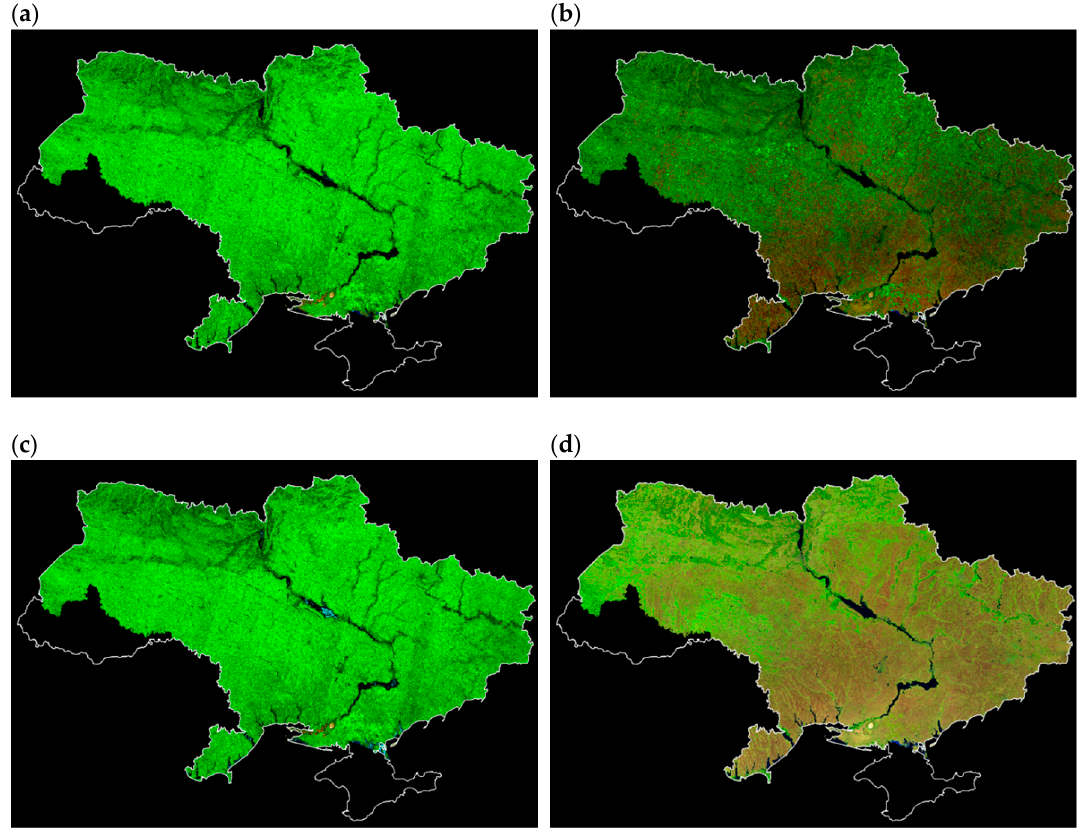
Figure 2. RGB images of seasonal composited mosaics (band combinations 6–5–4) of Landsat 8 OLI images for the flatland Ukraine and country outline (white line): ( a ) summer; ( b ) autumn; ( c ) yearly; ( d ) April–October. MVC composites were used for the visualization of ( a ), ( b ), and ( c ), and 1st quartiles of pixel values derived from time series applied for ( d ).